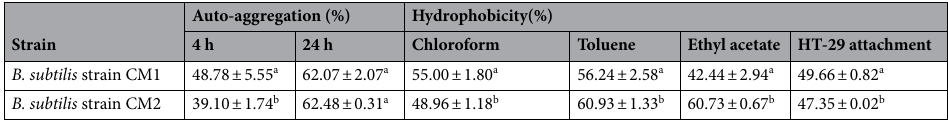
Table 4. Percentage of auto-aggregation, cell attachment and hydrophobicity traits of isolates. Cell surface characteristics are presented as mean ± SD of three replications. Isolates having different superscript letters differ significantly (P < 0.05).